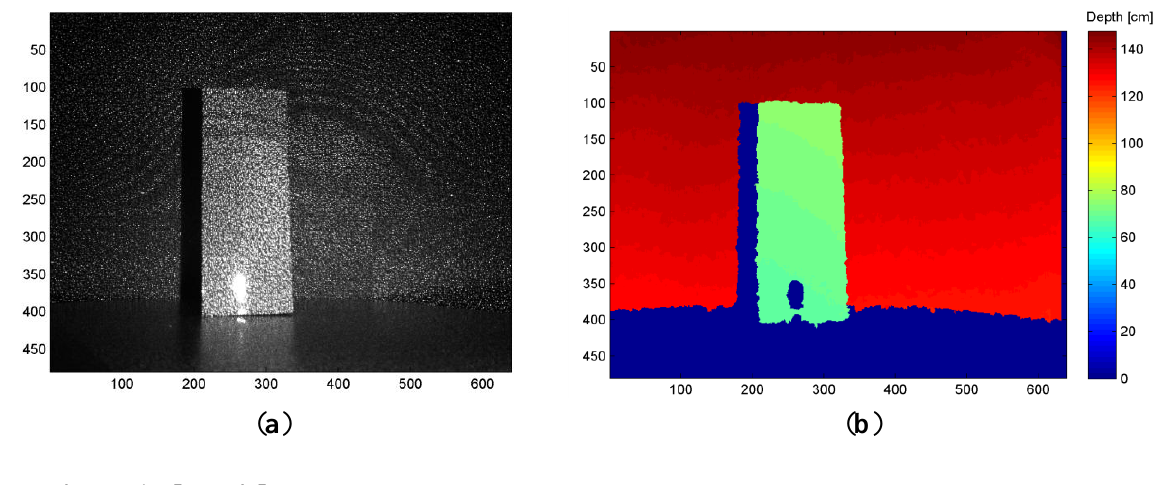
Figure 1. ( a ) Infrared image of the pattern of speckles projected on a sample scene. ( b ) The resulting depth image.